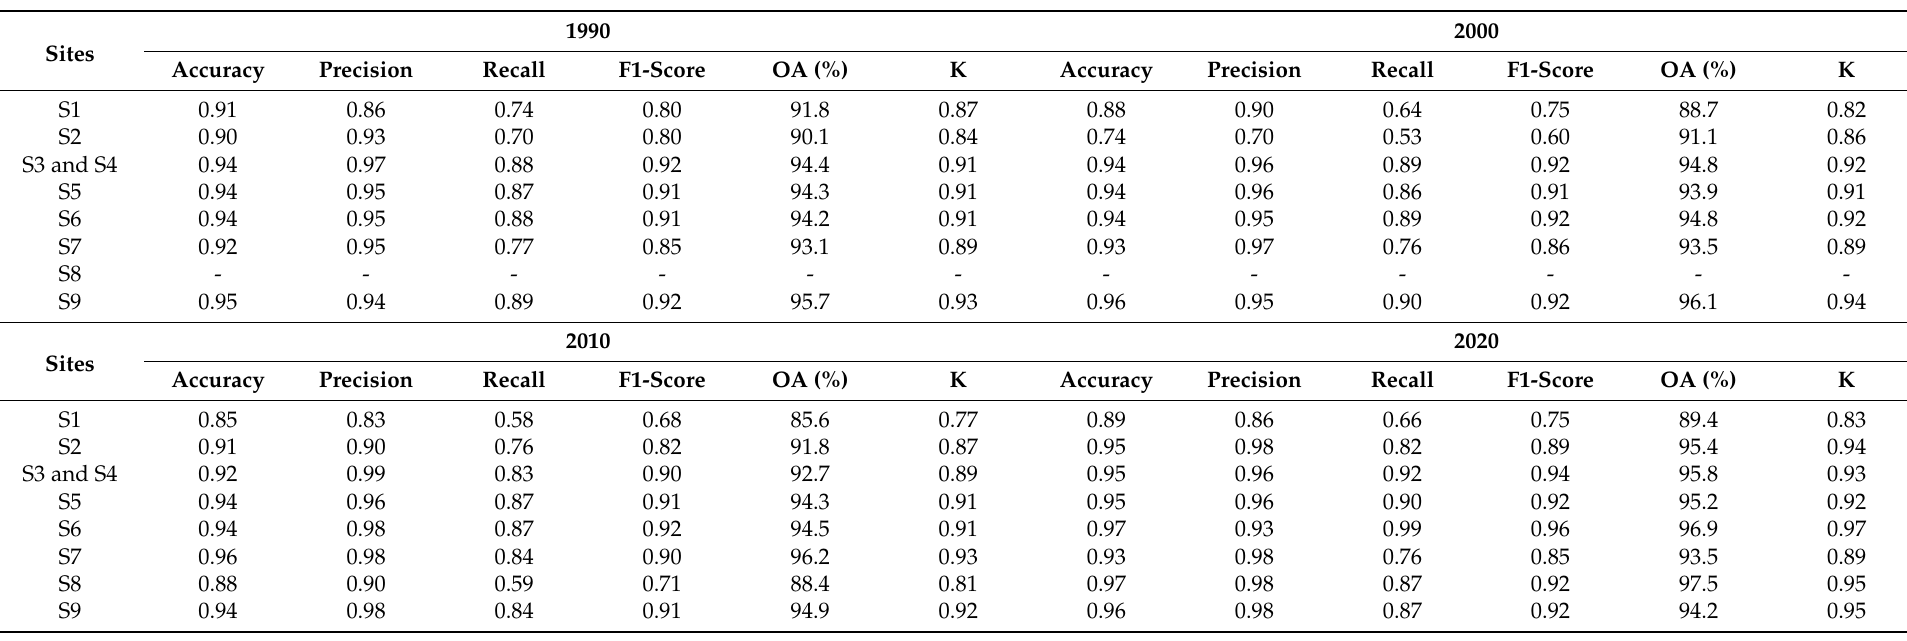
Table 3. The accuracy assessment of mangrove forest mapping from 1990 to 2020 with 10-year lags on the SMRI images of all study sites (Figure 1), classified by SVM algorithm (accuracy, precision, recall, and F1-score of mangroves; OA: overall accuracy; K: kappa